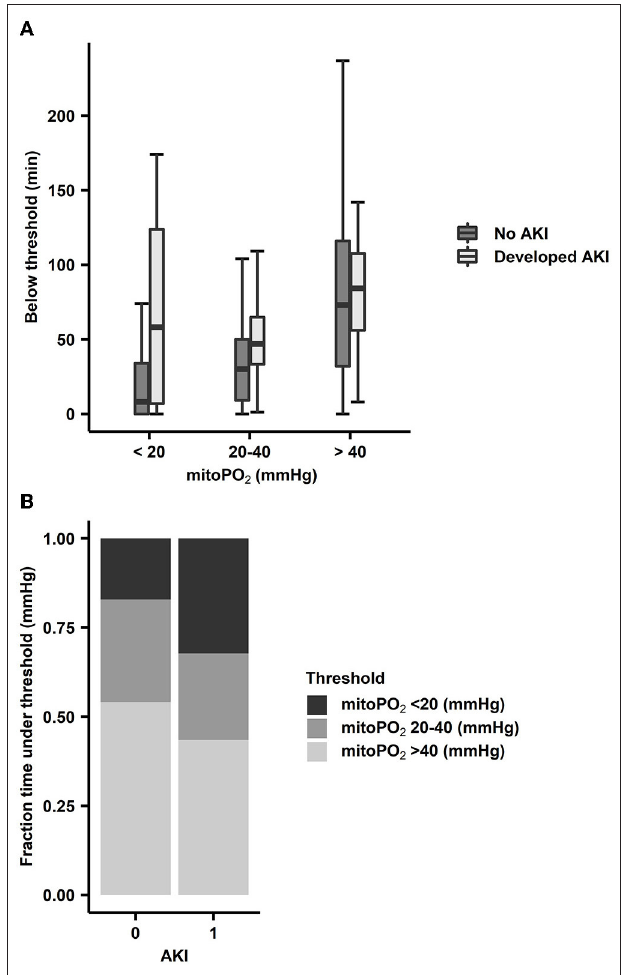
FIGURE 8 | (A) Absolute time within cutaneous mitoPO 2 ranges for AKI ( n = 4) patients and non-AKI ( n = 37) patients. The cutaneous mitoPO 2 ranges were below 20 mmHg, between 20 and 40 mmHg, and above 40 mmHg. Boxplot with median, IQR box, and whisker 1.5 times IQR, and outliers are not shown. (B) Time spent within a range as a proportion of CPB/extracorporeal circulation duration. Proportion is achieved by dividing the number of minutes below the threshold by CPB